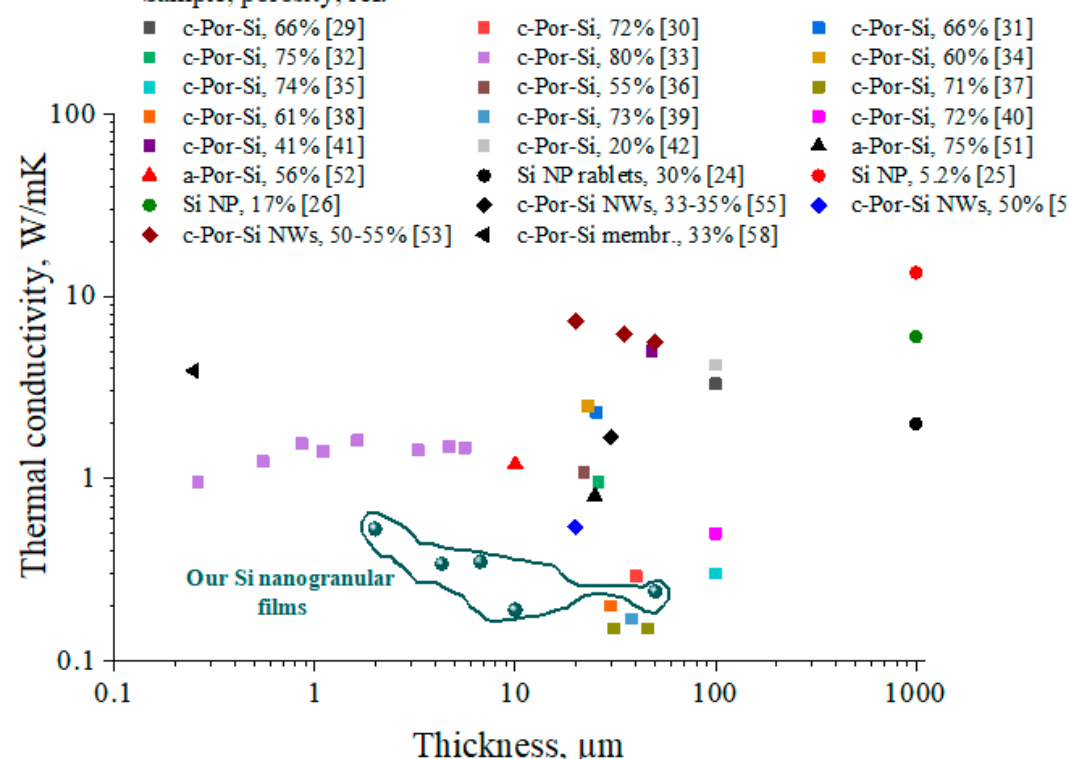
Figure 6. Measured thermal conductivity values of our Si nanogranular films with 70% porosity in comparison with other types of nanostructurally voided Si films (taken from the literature) versus different film thicknesses. Additionally, when the size of a nanostructure ≤ l MFP , phonons collide with inter- granular boundaries much more often than in single crystals. This additional phonon scattering mechanism suppresses heat flow between NPs and thus reduces the effective k of Si NP films compared to that of the bulk c-por-Si [65,66]. l MFP decreasing with the particle size, leads to the reduction in the effective k [67]. Finally, a long exposure of Si NPs to an ambient-air environment can result in their increased surface oxidation causing the formation of SiO 2 shells and leading to an additional decrease in their k